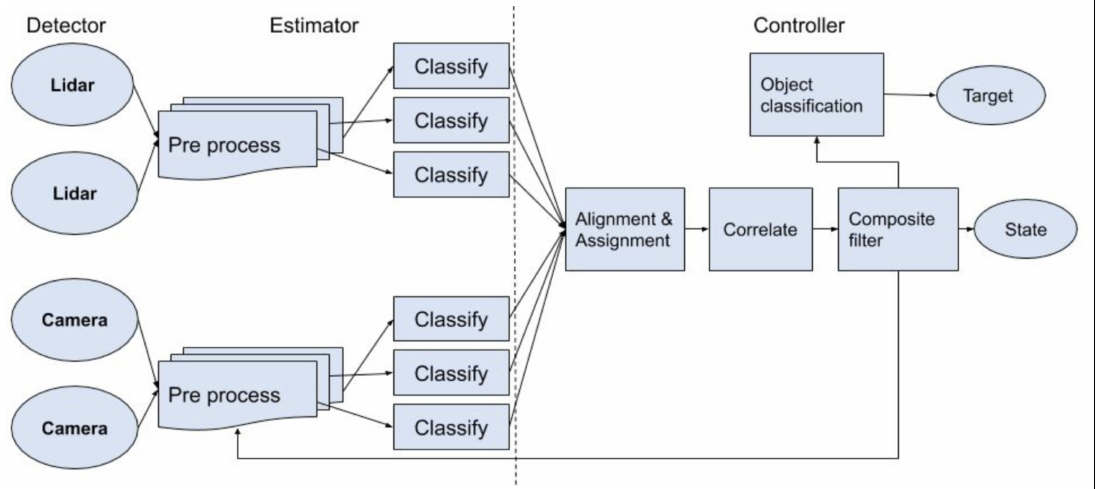
Figure 8. Architecture of a fusion